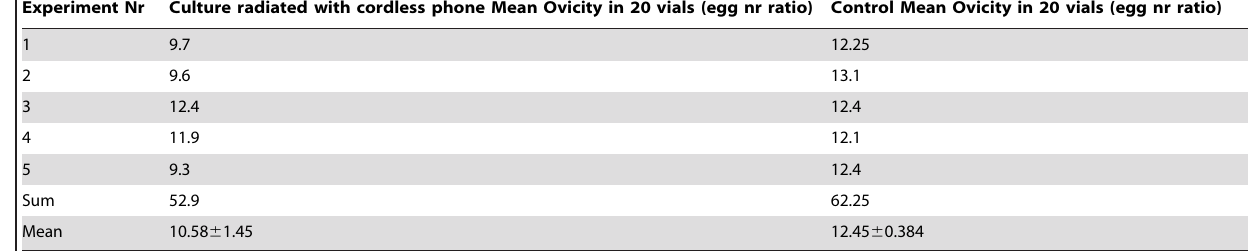
Table 1. Experimental results from cultures exposed to near field of a cordless phone (1880 MHz) p= 0.0445 between control and cordless phone radiated cultures.